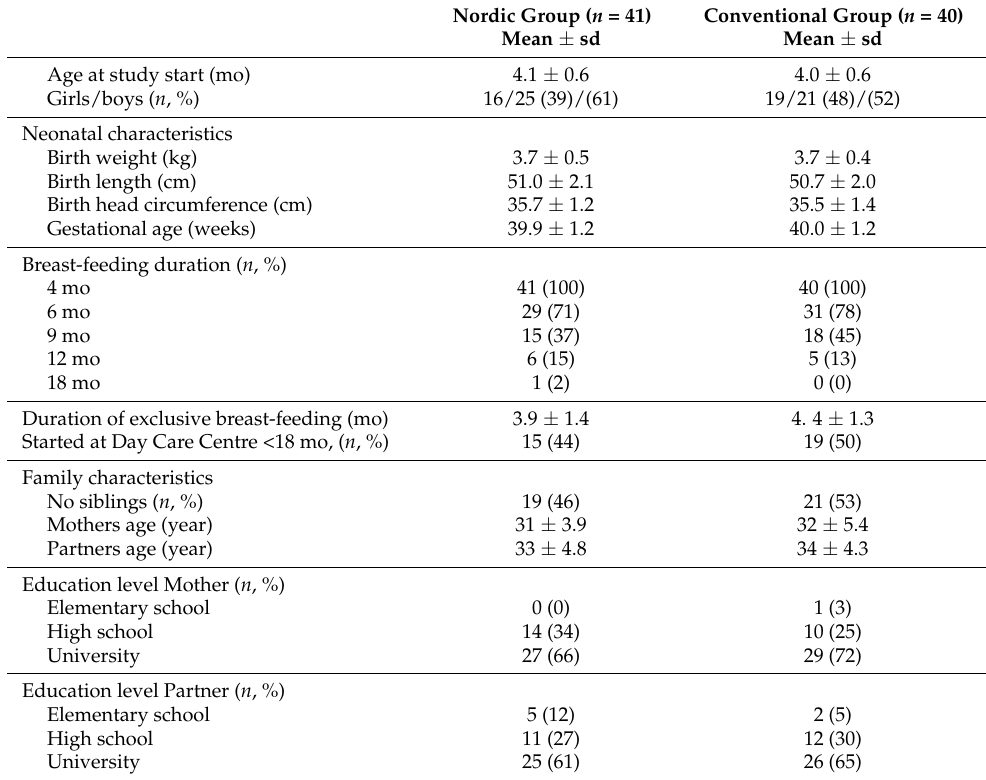
Table 1. Study participants’ characteristics, anthropometrical and biochemical